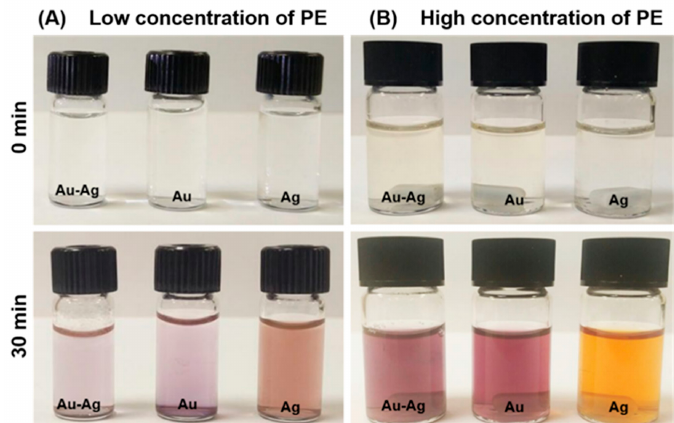
Figure 1. Ag, Au, and bimetallicalloy Au–Ag NPs with different concentrations of P. undulata PE; ( A ) lower concentration of PE and ( B ) higher concentration of PE.